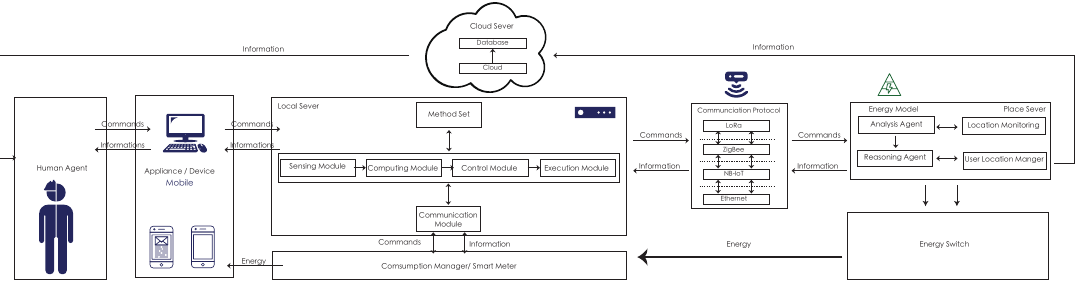
Figure 1. The system structure of the Sensible Energy System (SENS)